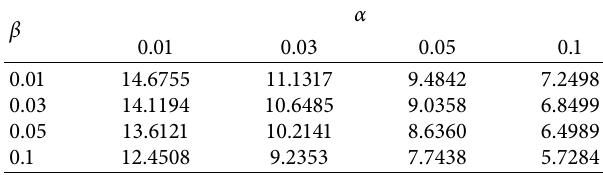
τ ∗ approximation. σ 2